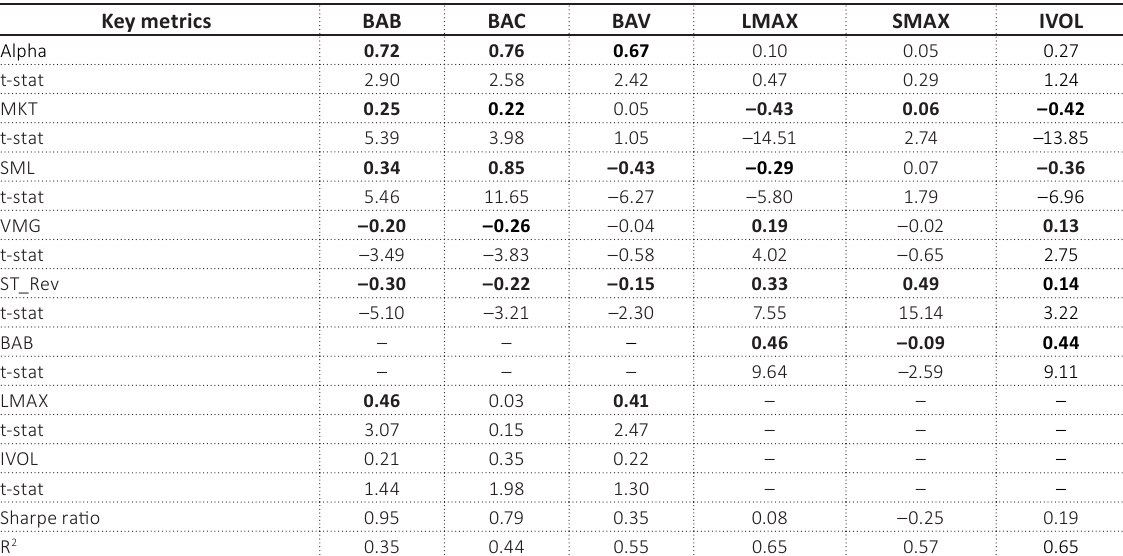
Table 9. Performance marathon among published